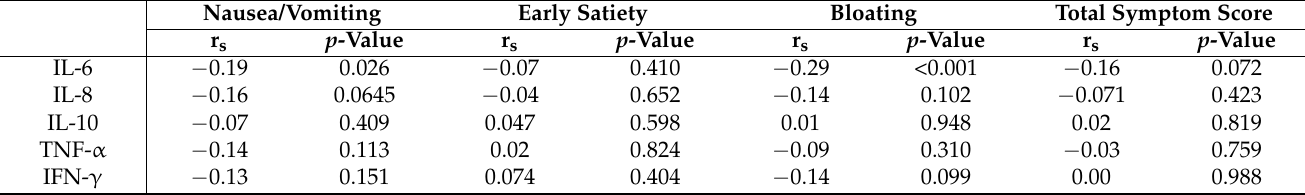
Table 3. Correlations between gastrointestinal symptoms and inflammatory markers.